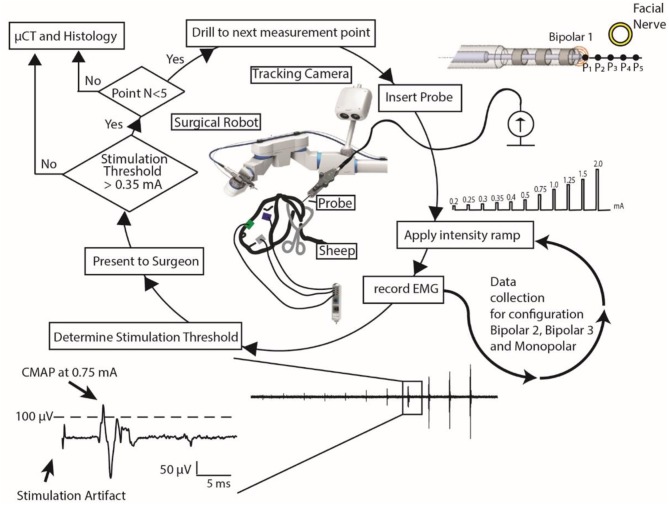
Nerve monitoring workflow: using a surgical robot and a stimulation probe, the surgeon follows this workflow to determine if it is safe to continue to drill or if she should stop. EMG data of only one EMG channel and only for stimulation electrode configuration Bipolar 1 is represented.